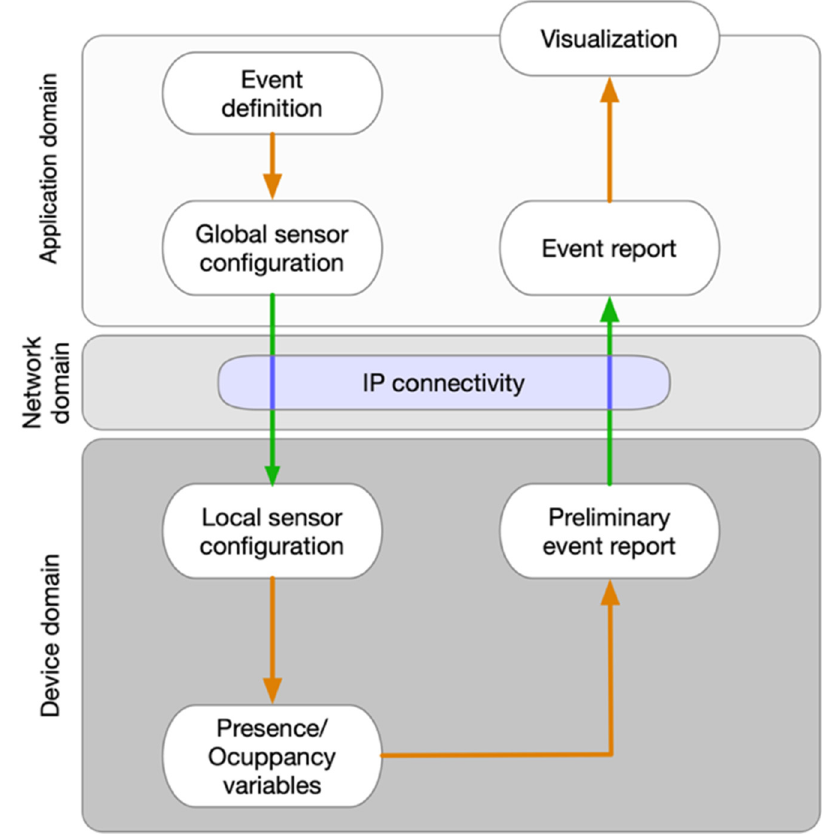
Figure 1. System architecture overview and information flow.